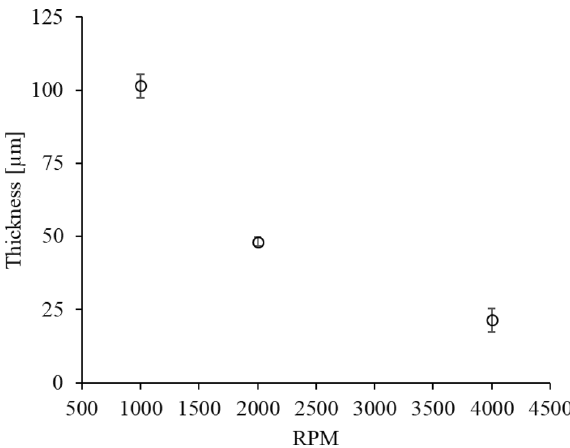
Figure 7. Thickness of the present porous PDMS layer, fabricated at t e = 150 °C and WMR = 0.5, depending on the spin-coating